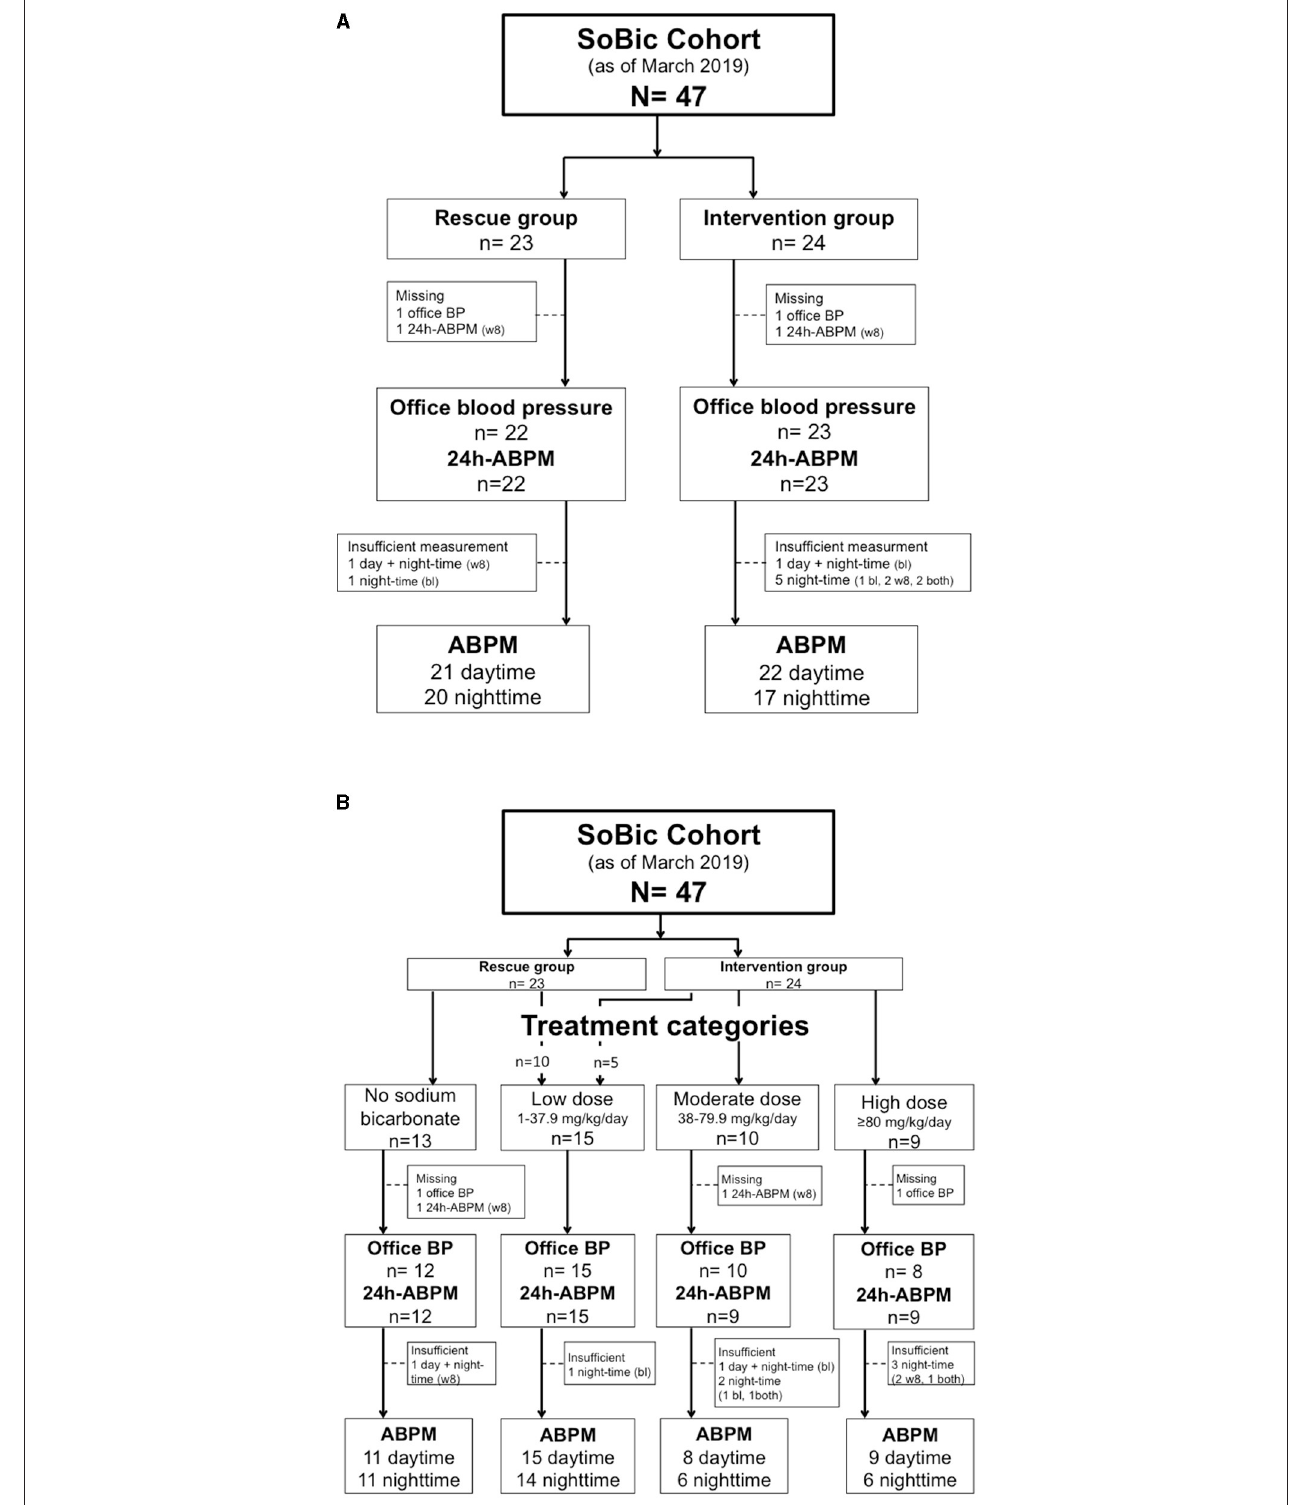
FIGURE 1 | Patient flow (A) according to study group and (B) according to treatment categories. 24h-ABPM, 24-h blood pressure monitoring; bl, baseline measurement; w8, week 8 measurement.